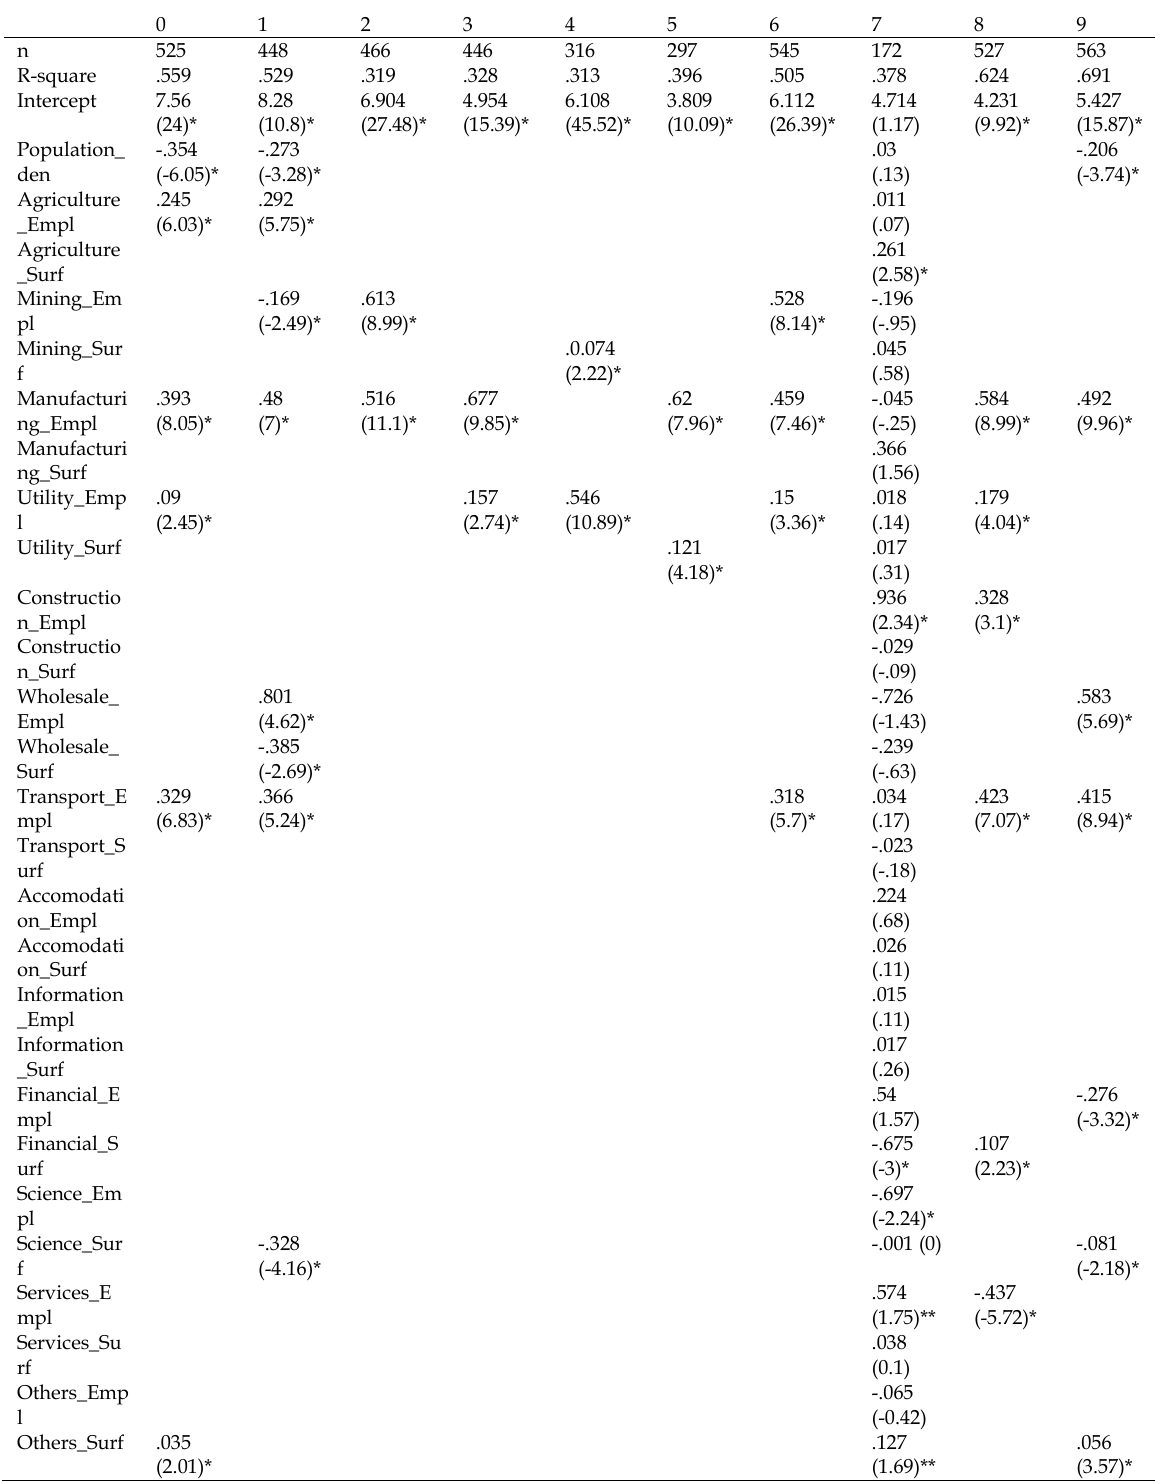
Table 5. Freight generation